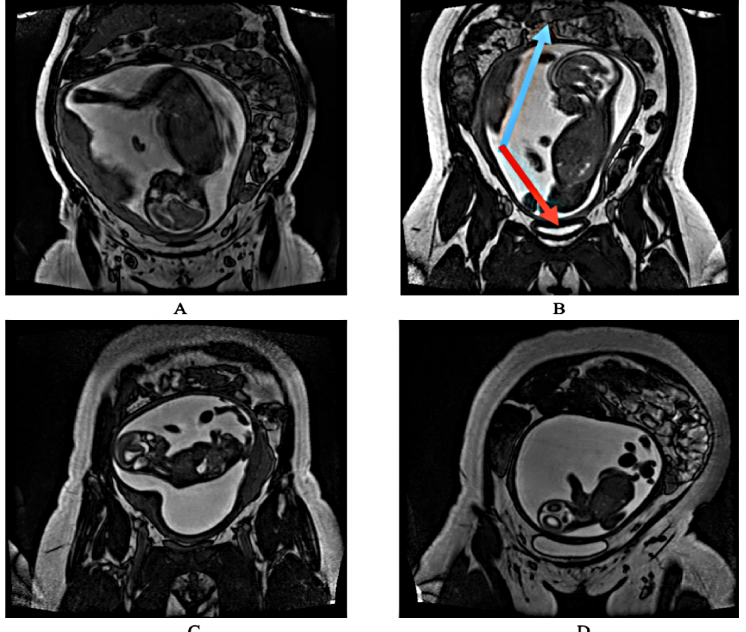
Figure 1. The four different labels of fetal orientation. ( A ) Vertex (head down). ( B ) Breech (head up). The blue arrow is pointing to the maternal intestines. The red arrow is pointing to the maternal blad- der. These two maternal organs were used as reference while manually labeling each two-dimensional (2D) slice based on the fetal orientation. ( C ) Transverse (sideways). ( D ) Oblique